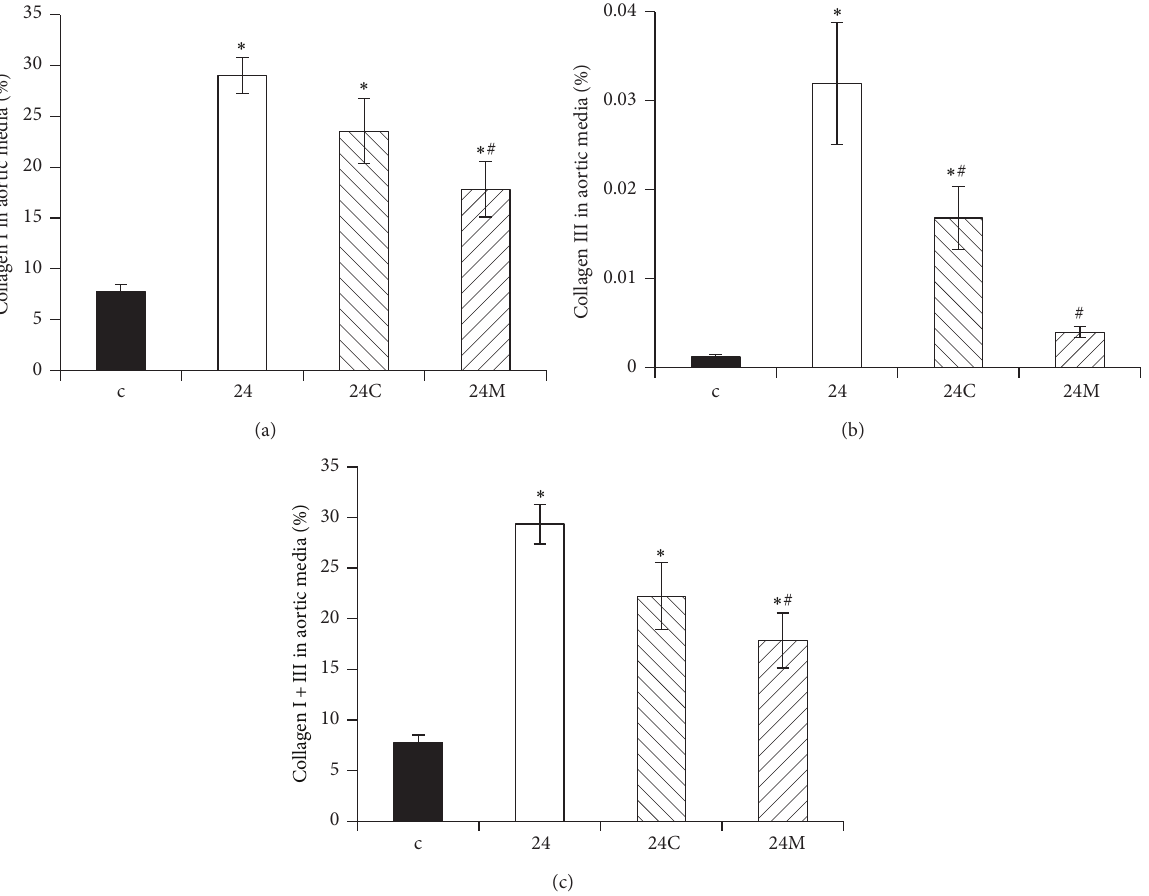
Figure 6: The influence of captopril (24C) and melatonin (24M) on the concentration of collagen I (a), III (b), and the sum of collagens I and III (c) in the aortic media in 24 hours/day continuous light exposure-induced hypertension (24). c: Wistar controls. ∗ 𝑃 < 0.05 versus c; # 𝑃 < 0.05 versus 24 (according to [36] with